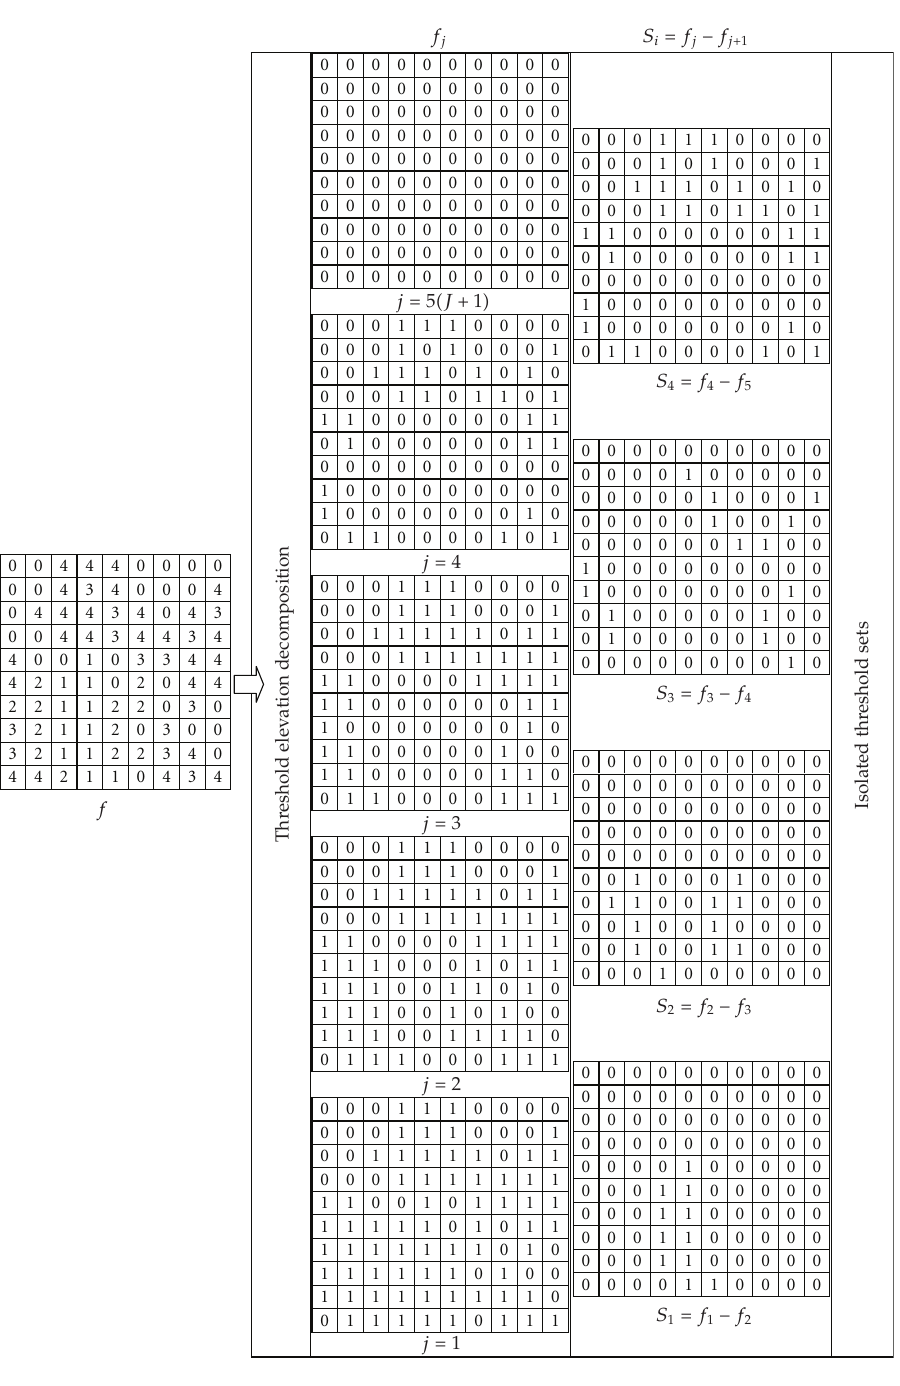
Figure 10: Original image f has maximum intensity level j (cid:9) 4. Threshold decomposed zones f j with j (cid:9) 1 , 2 , 3 , 4, and 5 (cid:2) J (cid:8) 1 (cid:3) are, respectively, shown along with the isolated sets with index i ranging from 1 , 2 ,...,j . The sets S i are isolated by f j − f j (cid:8) 1